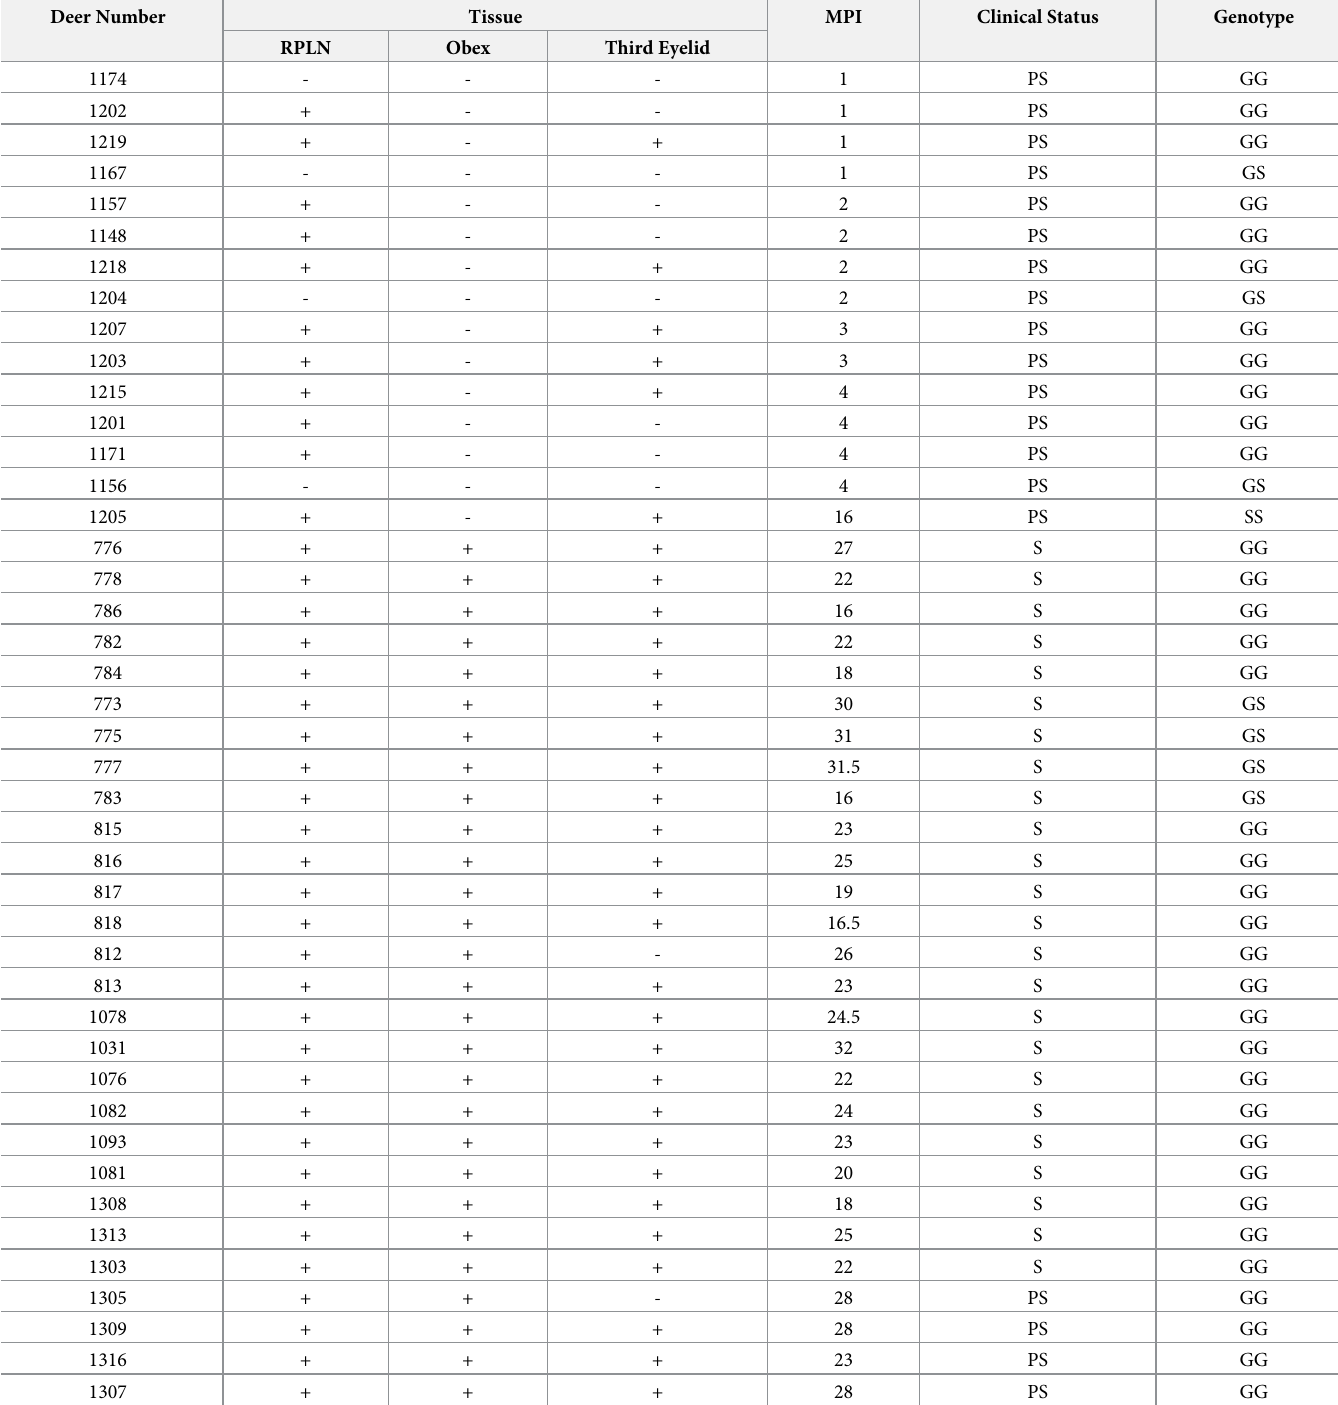
Table 2. Detection of PrP CWD in deer by RT-QuIC. Deer